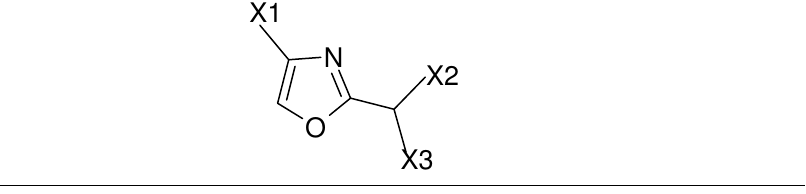
Table 1 Variation in the Physico-chemical properties for substituted Oxazoles as obtained using PC-Model